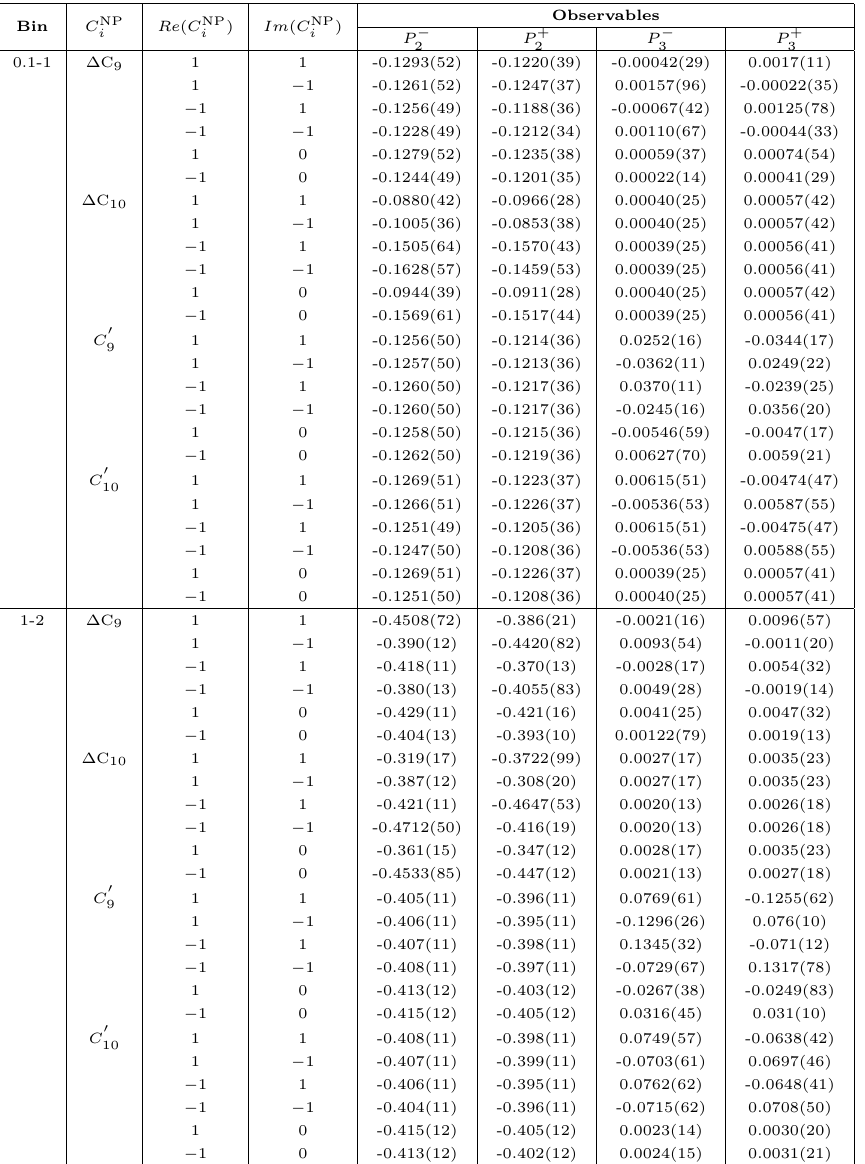
for the q 2 bins 0 . 1 − 1 9 , 10